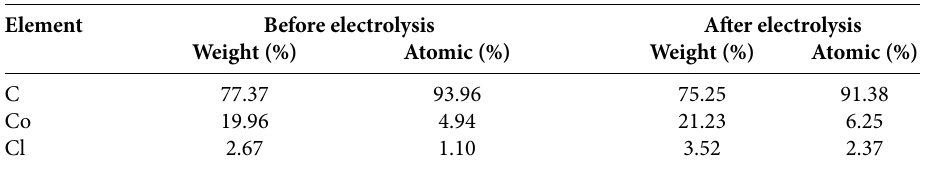
Table 3. Elemental composition of Co 47.5 /C 47.5 -PVC 5 electrode before and after electrolysis of RB21 solution.